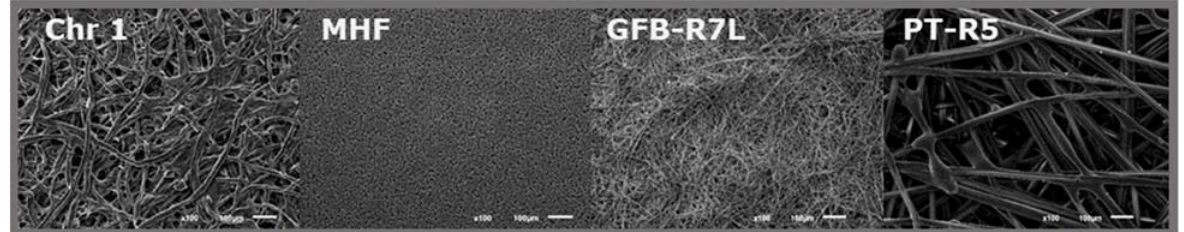
Figure 2. SEM images (zoom × 100) of different paper substrates: Chr 1: Whatman Grade 1; MHF: Millipore Hi-Flow nitrocellulose membrane; GFB-R7L: Mdi glass fiber; and PT-R5: Mdi polyester. Reprinted (adapted) from [40], Copyright (2017), with permission from Elsevier.